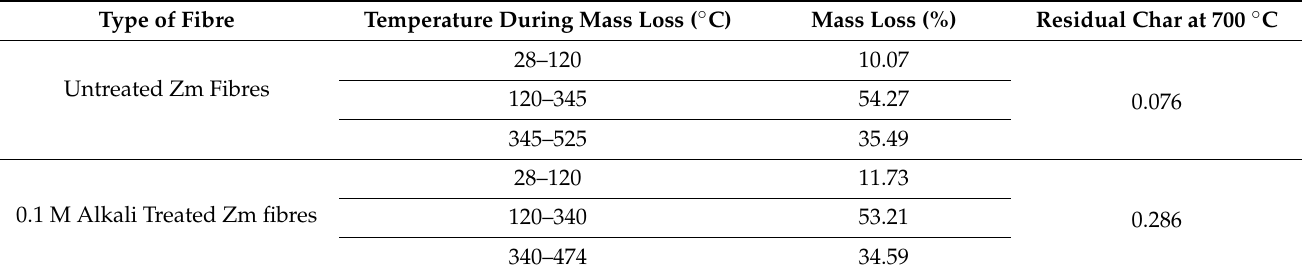
Table 6. Thermal study of untreated and alkali treated Zm fibres. Type of Fibre Temperature During Mass Loss ( ◦